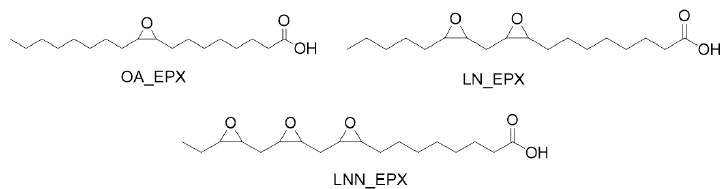
Figure 4. Structures of the products obtained from the enzymatically catalyzed epoxidation of oleic, linoleic, and linolenic acids. Codes refer to marine biodegradation tests. Table 3. Experimental conditions for the epoxidation of pure oleic, linoleic, and linolenic fatty acids. Reactions were performed in the presence of immobilized CaLB (Novozyme 435) on a 2 g scale at 50 ◦ C. The molar ratio between C=C bonds and H 2 O 2 = 1:2.